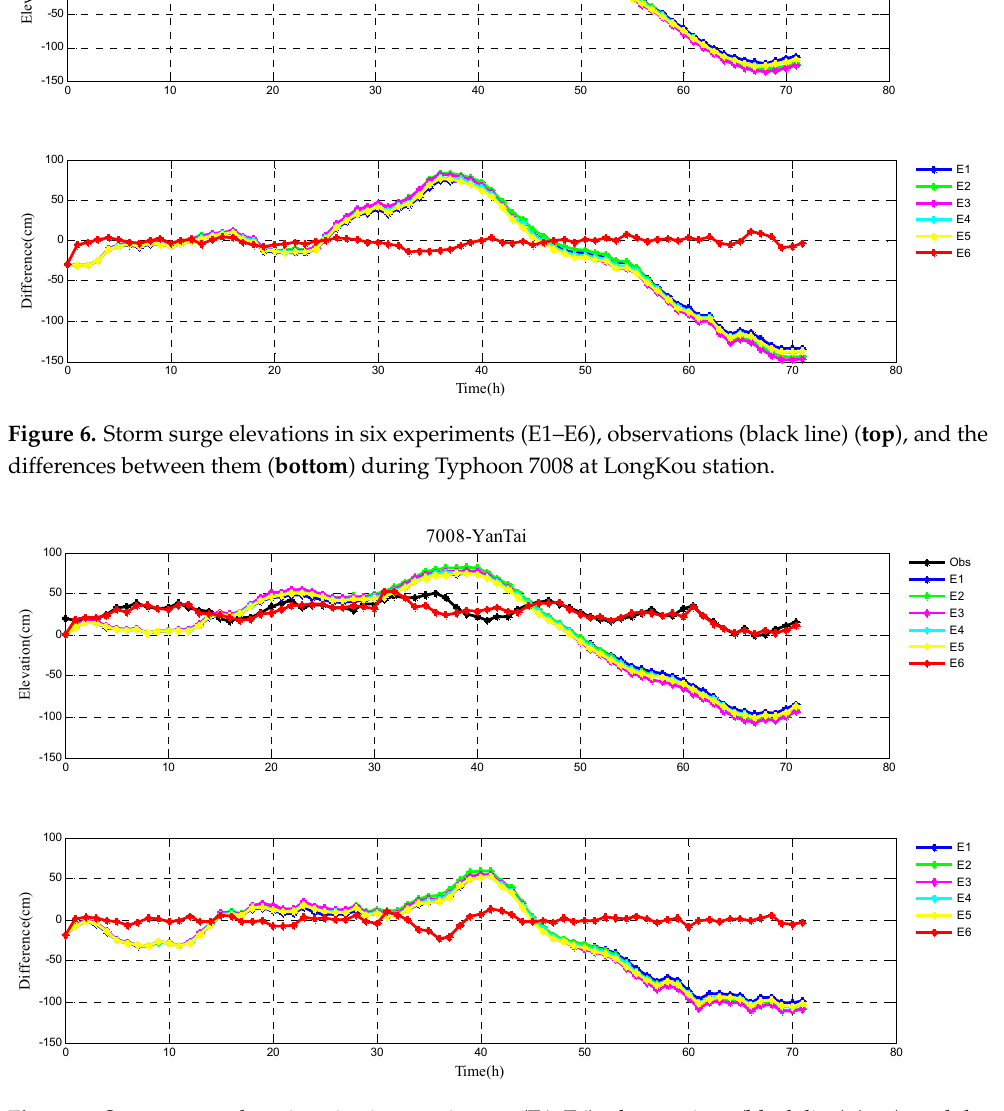
Figure 7. Storm surge elevations in six experiments (E1–E6), observations (black line) ( top ), and the differences between them ( bottom ) during Typhoon 7008 at YanTai station.